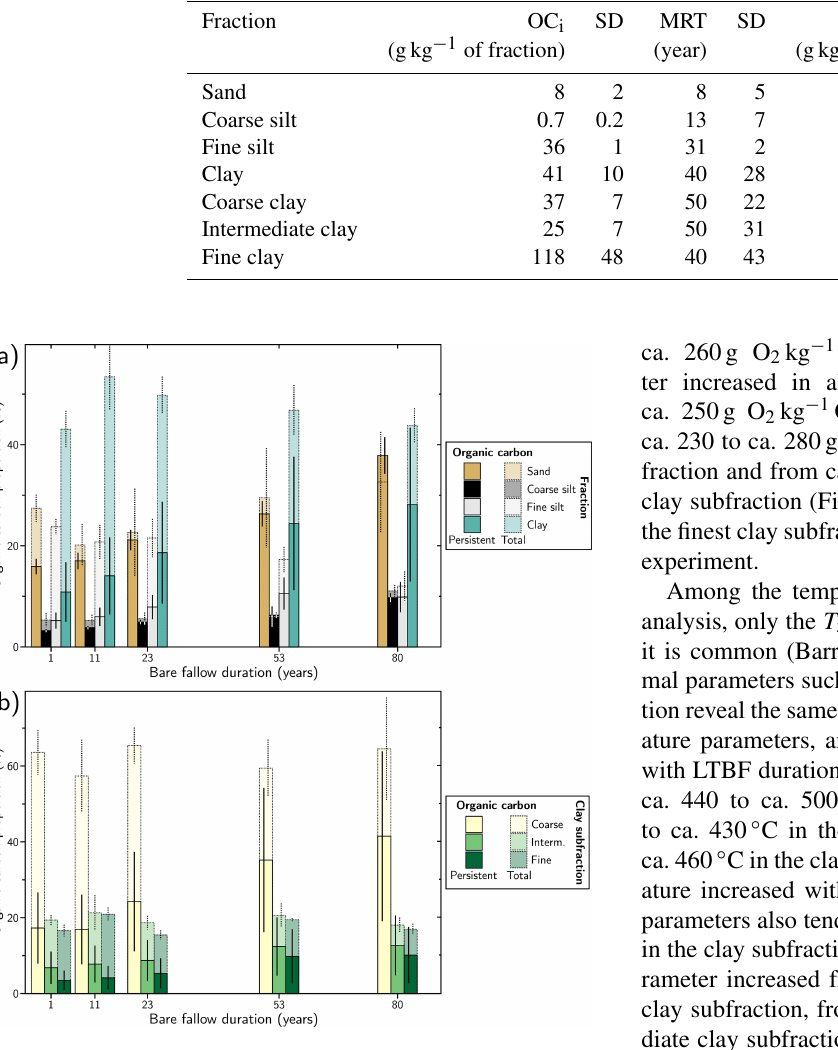
Figure 2. Evolution of the organic carbon proportion contained in the studied size fractions with duration of the LTBF experi- ment: (a) sand ( > 50µm), silt (coarse: (20–50)µm, fine: (2–20)µm) and clay ( < 2µm) fractions; (b) coarse ((0.2–2)µm), intermediate ((0.05–0.2)µm) and fine ( < 0.05µm) clay subfractions. The error bars, corresponding to 2 standard deviations, are calculated from the standard deviation of the organic carbon content and of the mass of the fraction measured for the four plot replicates. The proportion of persistent organic carbon (dark colour) is obtained from exponen- tial decay fitting using the OC p (persistent organic carbon) param- eter. The error bars, corresponding to 2 standard deviations, are es- timated from the standard deviation of the OC p parameter obtained from the fit and the standard deviation of the mass of the fraction measured for the four plot